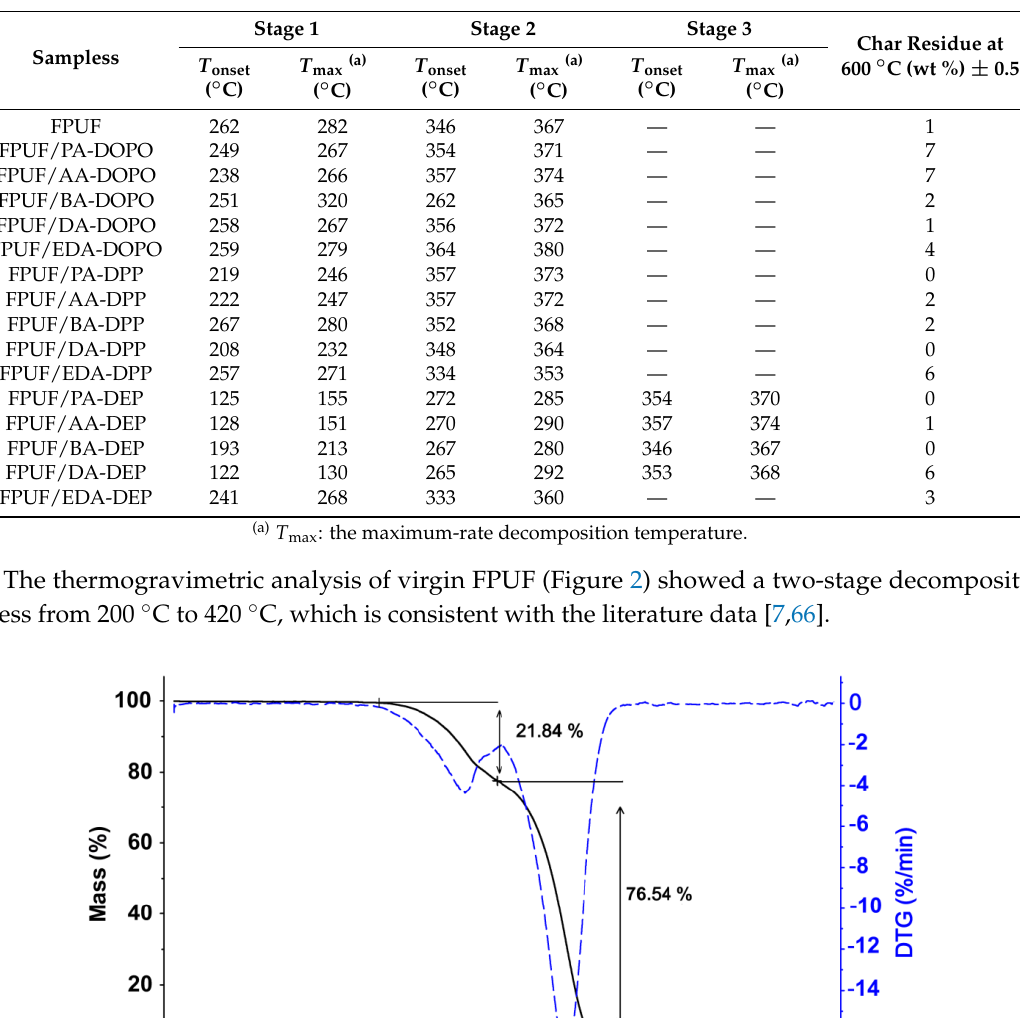
Table 4. TGA data of flame retarded FPUF.